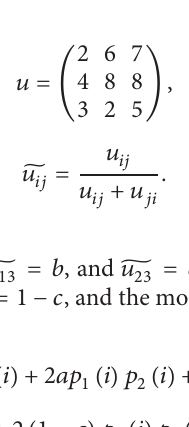
of free combination for (𝑝 3 , 𝑝 1 ) is ̃𝑢 31 ; the probability of free combination for (𝑝 3 , 𝑝 2 ) is ̃𝑢 32 .